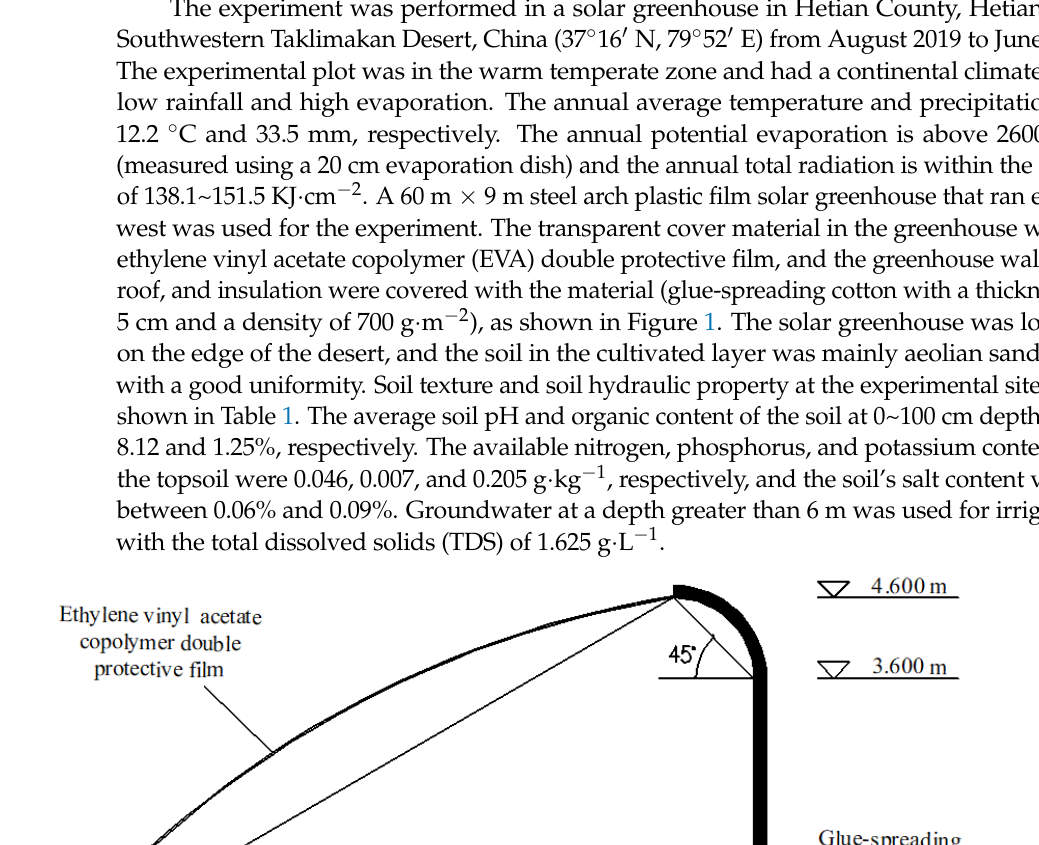
Table 1. Soil texture and soil hydraulic property at the experimental site.